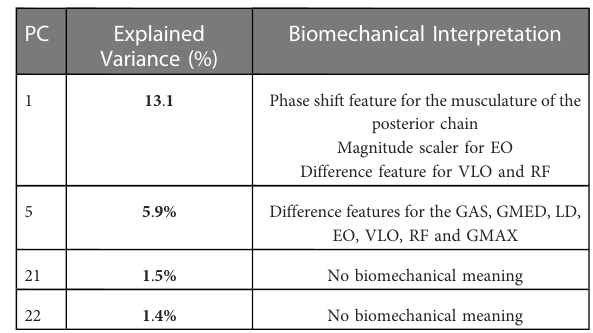
TABLE 5 Summary of explained variance and biomechanical interpretation for PCs retained from the EMG dataset.